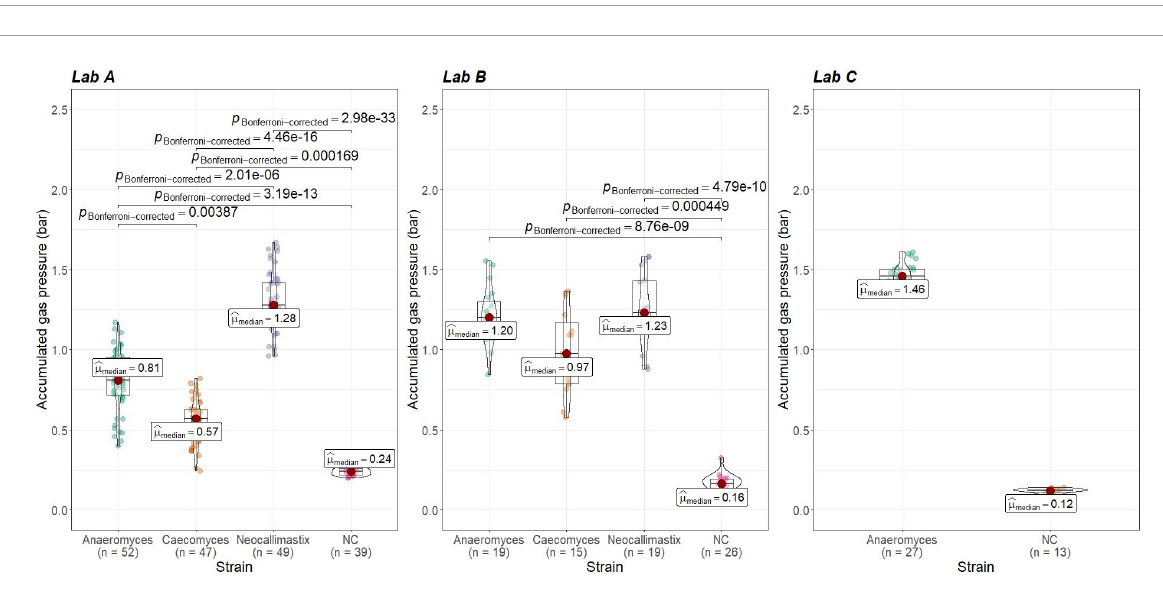
FIGURE6 Comparisons of accumulated gas pressure in the positive controls of the three different AF-methanogen co-cultures within the three partnering laboratories (lab A, lab B, lab C). Lab A and Lab B: statistical tests: Kruskal-Wallis with post hoc Dunn-test. Only significant pairwise comparisons are shown. Lab C: statistical test: Mann–Whitney U, p =